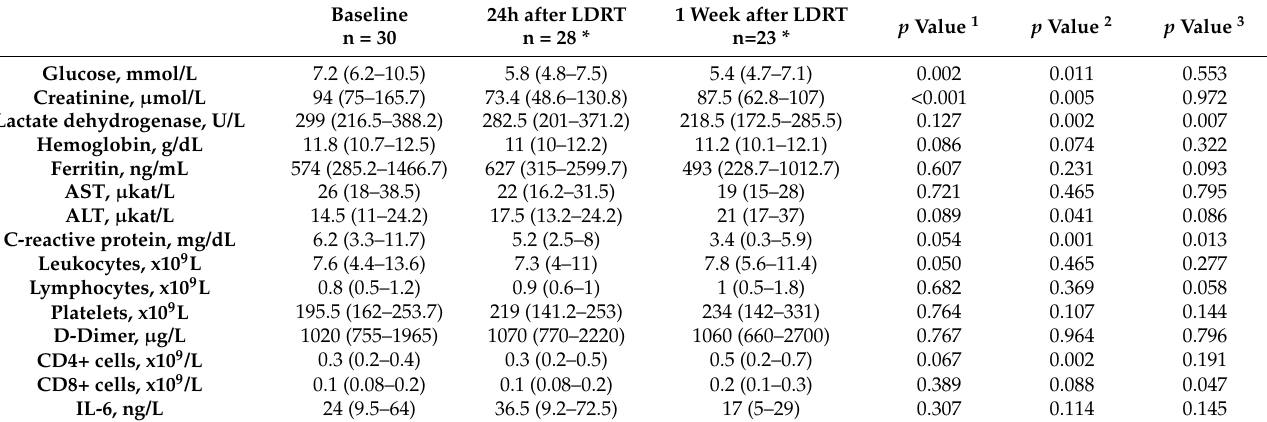
Table 3. Biochemical parameters at basal, 24h and 1 week after low-dose radiation therapy